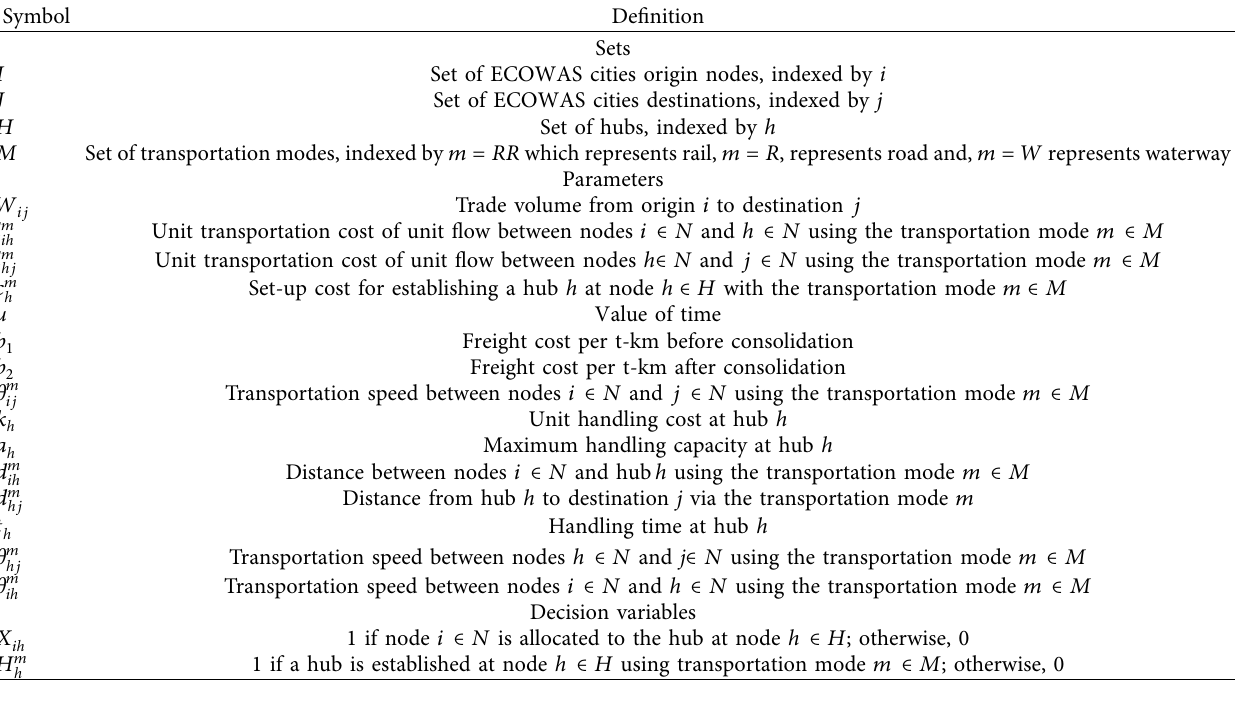
Table 6: Explanation of